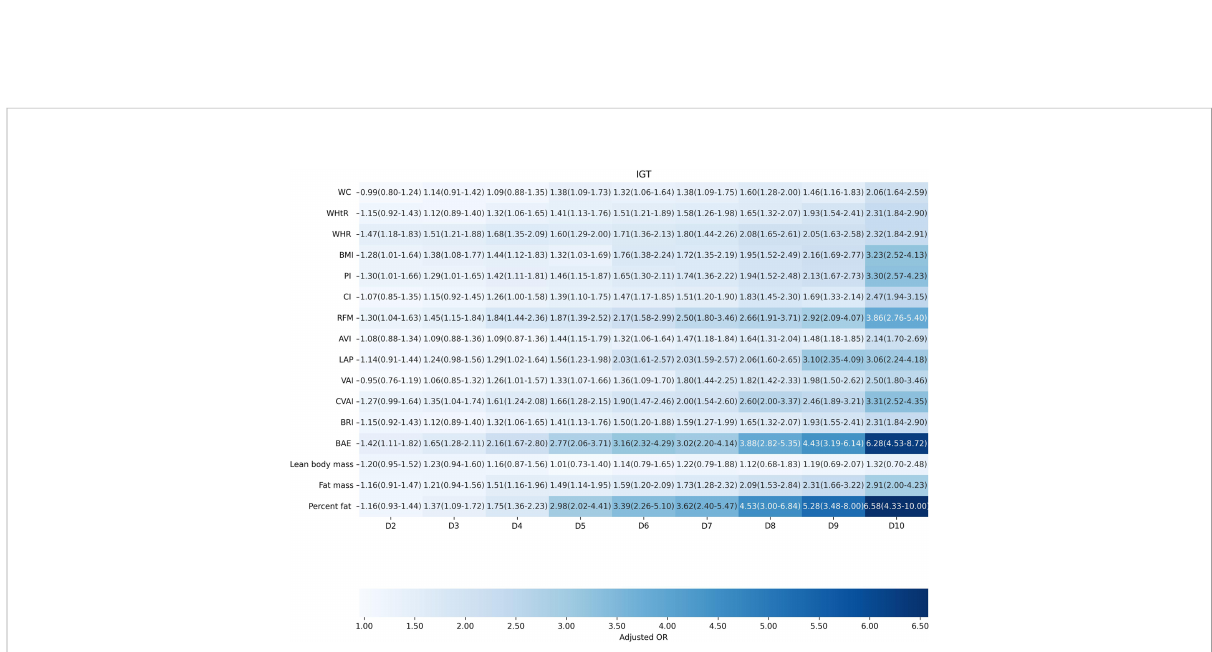
FIGURE 4 The association between deciles of obesity indicators and impaired glucose tolerance. The fi rst decile (D1) was used as reference. Adjusted for age, gender, education level, equivalent household income, drug history, family history of diabetes, smoking status, drinking status, regular exercise, hypertension, TC, LDL-C, HDL-C, and TG; for lean body mass, fat mass and height were further adjusted; for fat mass, lean body mass and height were further adjusted. WC, waist circumference; WHtR, waist-to-height ratio; WHR, waist-to-hip ratio; BMI, body mass index; PI, ponderal index; CI, conicity index; RFM, relative fat mass; AVI, abdominal volume index; LAP, lipid accumulation product; VAI, visceral adiposity index; CVAI, Chinese visceral adiposity index; BRI, body roundness index; BAE, body adiposity